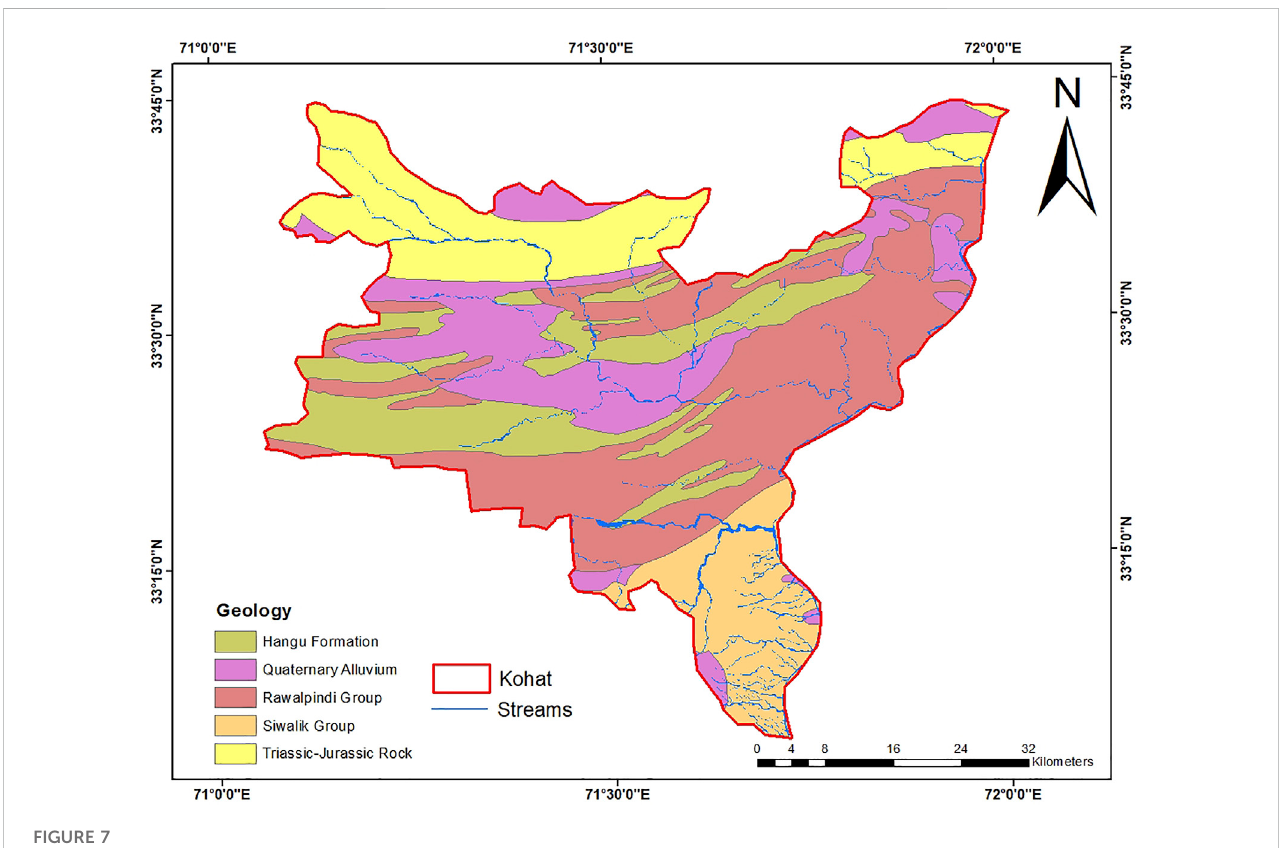
FIGURE 7 Geological map of the study